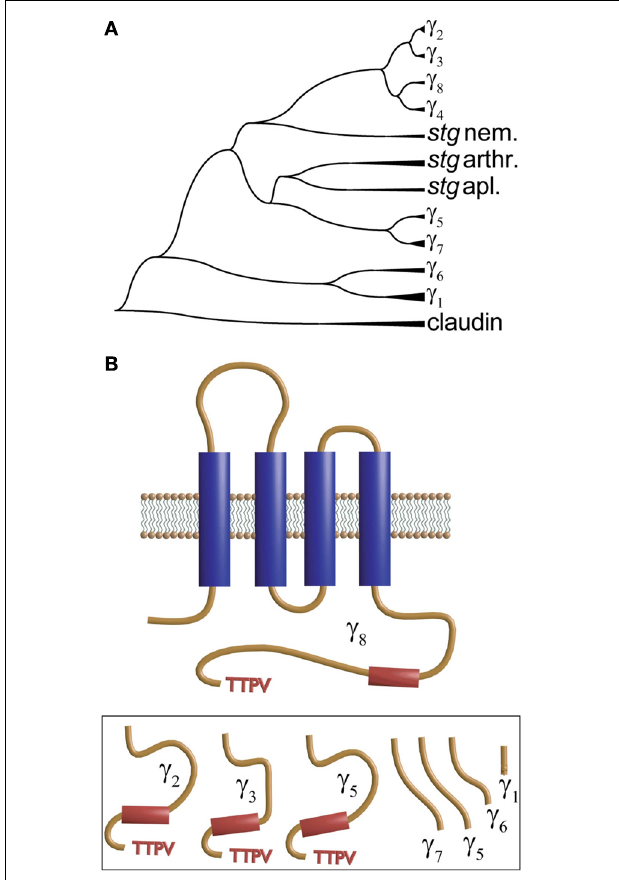
FIGURE 4 | Dendrogram and transmembrane topology of the γ subunit. (A) Phylogenetic dendrogram constructed using CLUSTAL to align CACNG sequences from vertebrates (zebra fish, human and Xenopus ) and invertebrates. Proteins labeled stg nem., stg arthr. and stg apl. refer to stargazin from nematode, arthropod and aplysia, respectively. (B) The γ -subunit encompasses four transmembrane domains and a C-terminus that varies significantly among the different forms and that in γ 2 , γ 3 , γ 5 and γ 8 (shown in the inset below) ends in a TTPV motif that tethers the protein to the PDZ